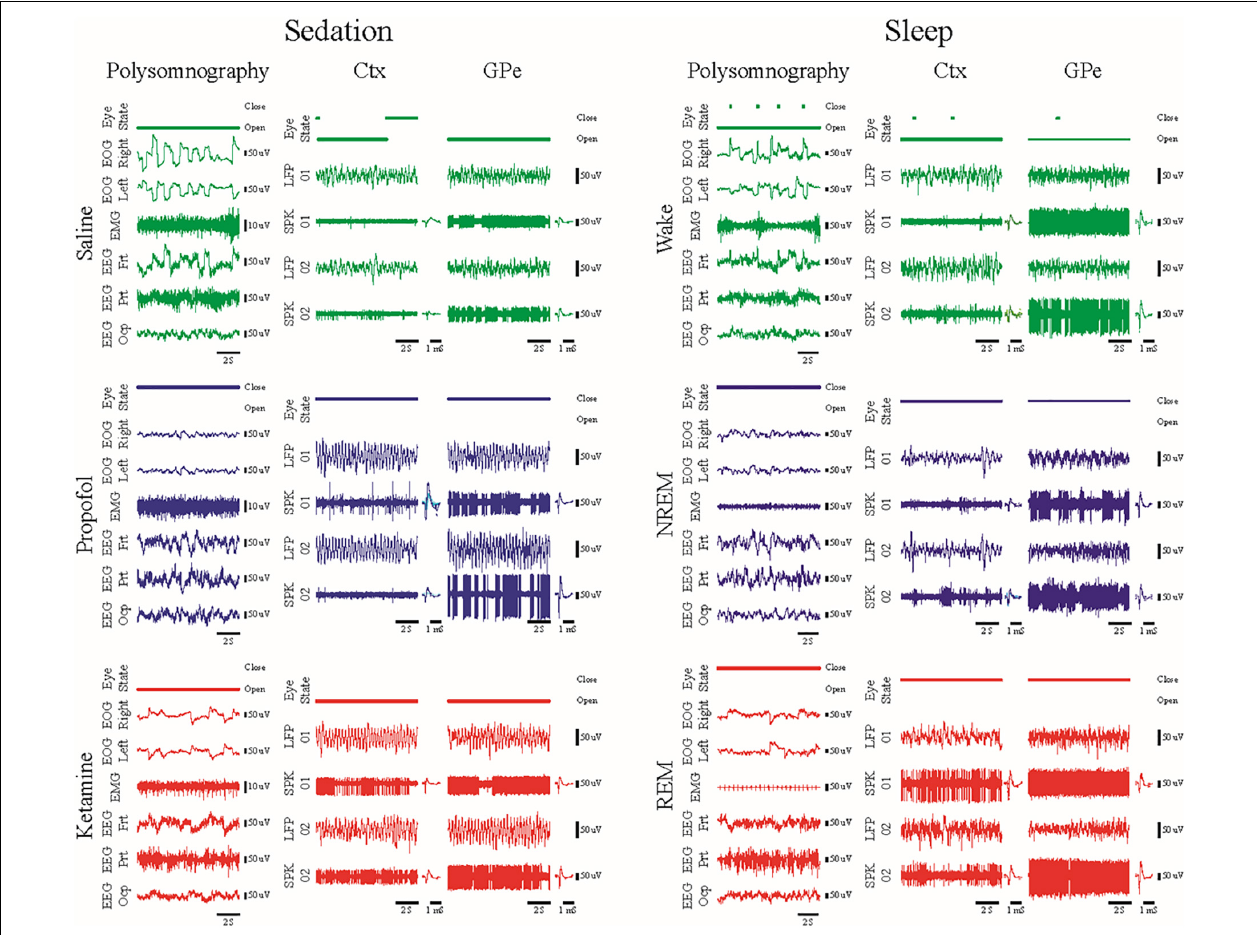
FIGURE 2 | Examples of 10 s traces of polysomnography (eye open/close state, EOG, EMG and EEG), local field potential and spiking activity (LFP/SPK) recorded in the frontal cortex and the external segment of the globus pallidus (Ctx/GPe) during sedation sessions (left, saline baseline—upper, green; propofol—center, blue; and ketamine—lower, red) and during the awake-sleep cycle (right, wake—upper, green; NREM—center, blue; and REM—lower, red). Modified with permission from Guang et-al 2021 (Guang et al.,